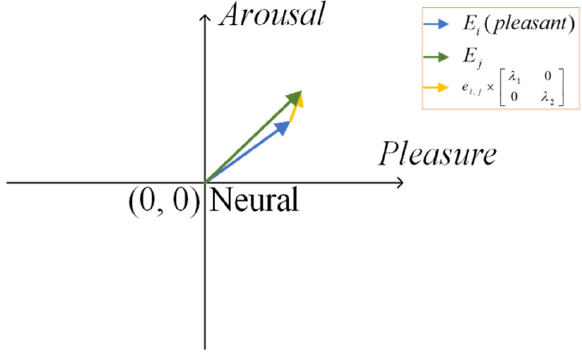
Figure 2. A schematic diagram for Equation (1).